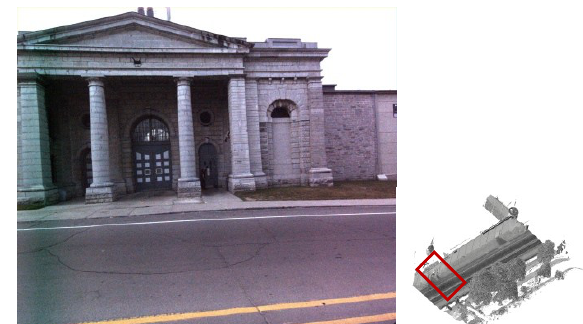
Figure 3. A pavement image taken by the digital